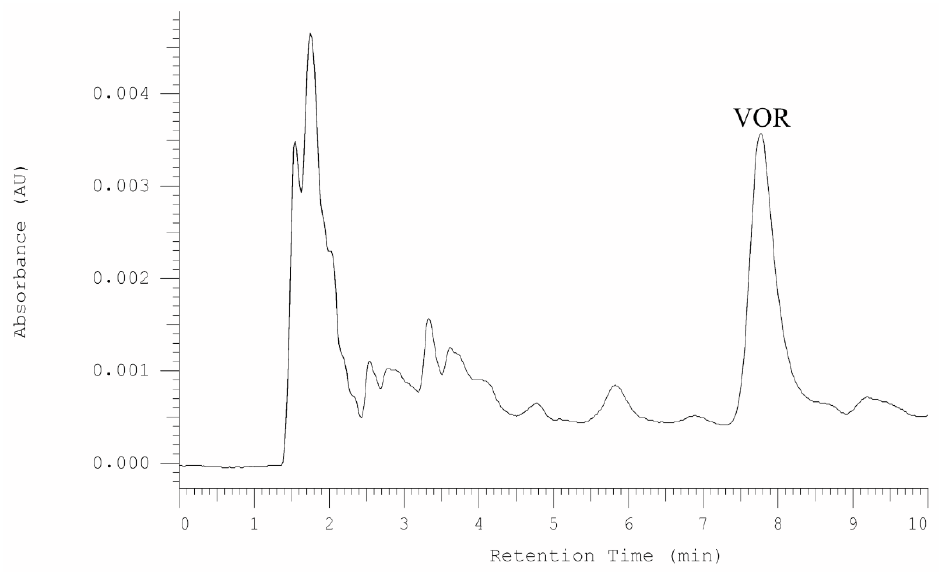
Figure 2. HPLC-DAD chromatogram obtained for serum sample from patent treated by vortioxetine. The sample was taken 24 h after drug administration.